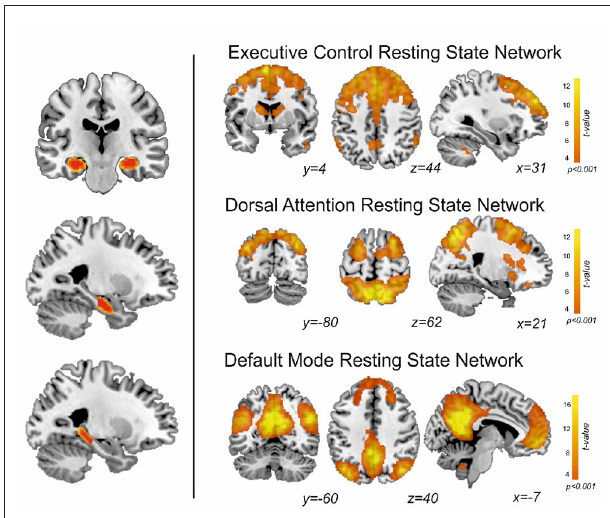
FIGURE 1 | On the left, segmentation of both hippocampi, and division along the anterior-posterior axis. On the right, the resting state networks obtained in this study from patients and